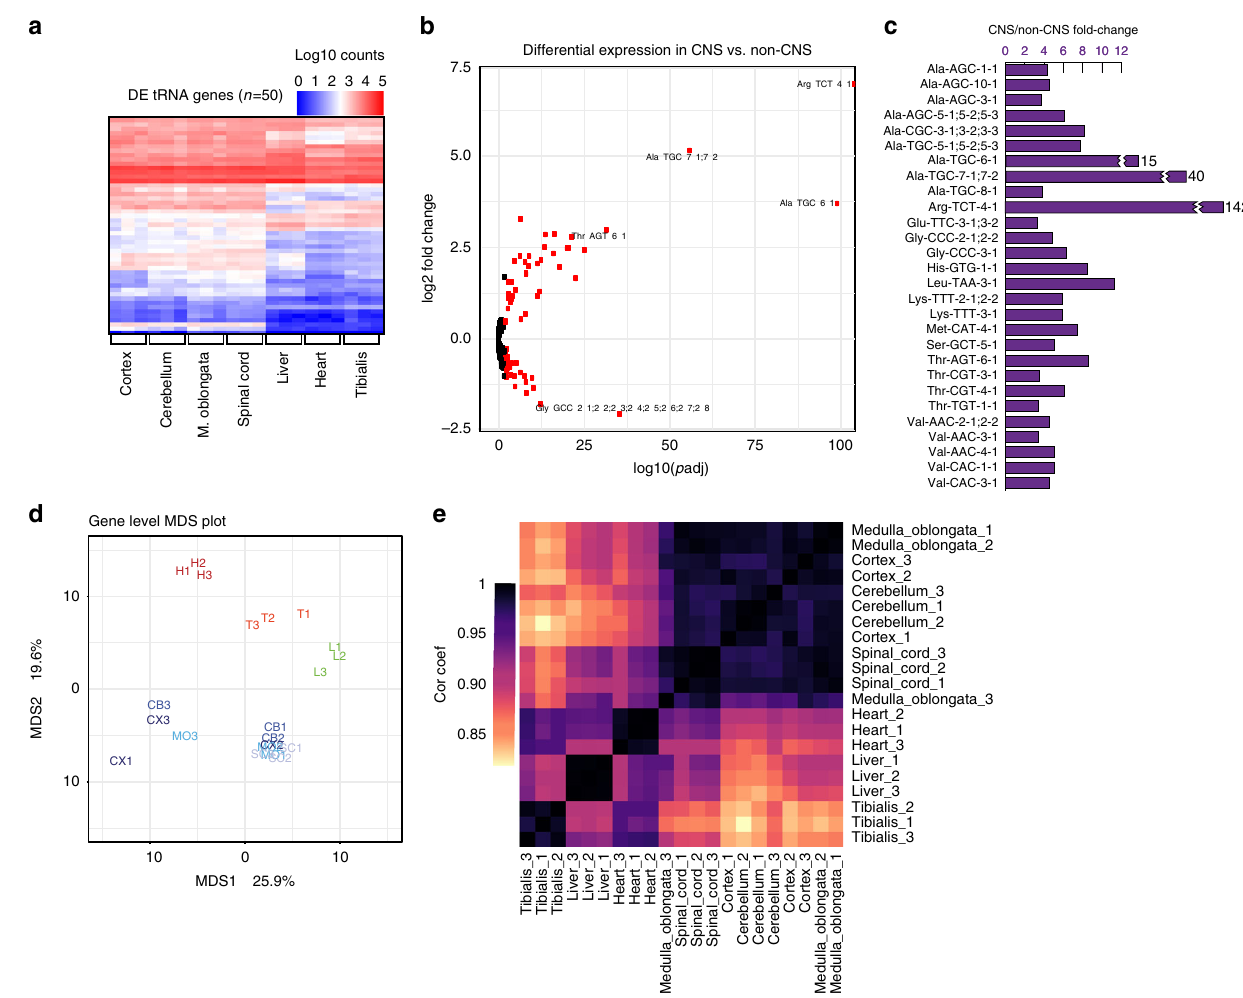
Fig. 4 tRNA isodecoders change across mouse tissues. a Heatmap of log 10 -transformed tRNA isodecoder expression for isodecoders that signi fi cantly change across tissues ( p < 0.01). Hierarchical clustering was used to group isodecoder expression along the y -axis. b The volcano plot of all isodecoders from the comparison of all samples lumped into two bins: CNS (cortex, cerebellum, medulla oblongata, spinal cord) versus non-CNS (liver, heart, tibialis). Isodecoders with a p value of 0.01 or less are colored red. Highly signi fi cant, tissue-speci fi c isodecoders are labeled with their names. c Isodecoders that exhibit padj < 0.01 and CNS/non-CNS fold-change> 3 are depicted. d The expression matrix (RPM) used to generate ( a ) was used to generate a distance matrix and multidimensional scaling plot to examine the distance between tissues with regards to tRNA expression at the isodecoder level. CNS tissues are labeled in shades of blue, non-CNS muscle tissues are in red, and the non-CNS liver is in green. e Pearson correlation coef fi cients between tRNA isodecoder expression pro fi les of all tissues were plotted as a heatmap. Hierarchical clustering was used to group tissues along the x and